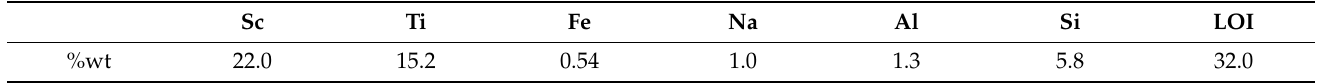
Table 4. Crude Sc concentrate chemical